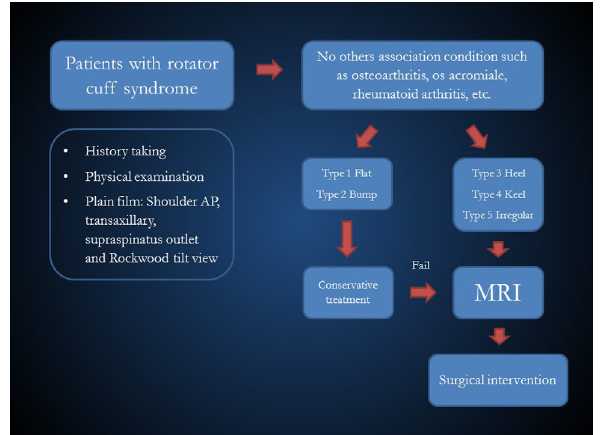
Figure 5. The diagram for the evaluation of patients with rotator cuff syndrome which utilizes the arthroscopic classification as the factor to